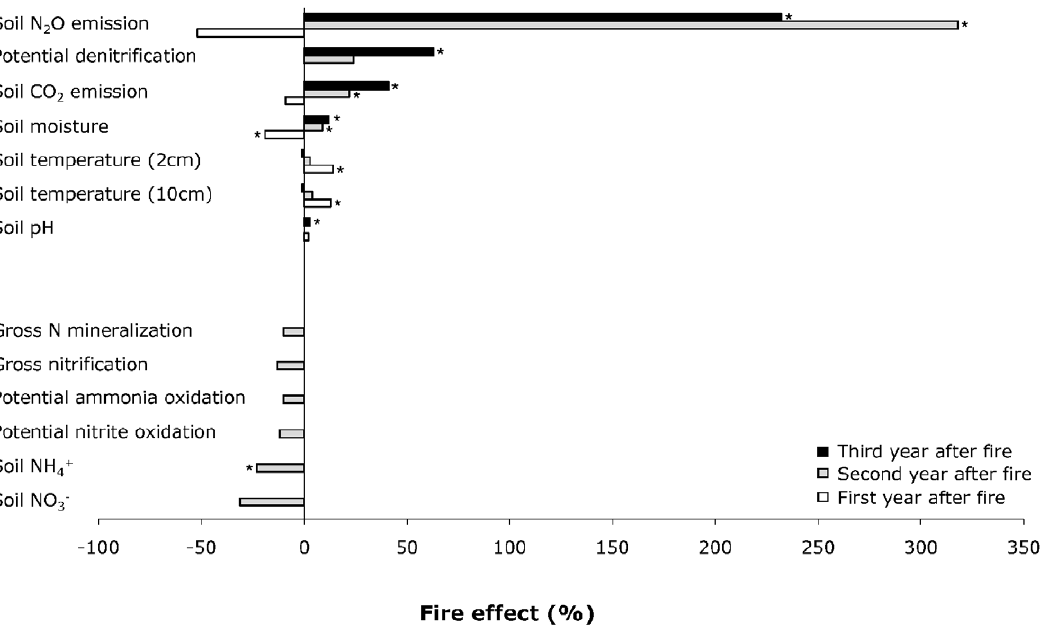
Figure 3. Effects of fire on soil N 2 O emissions, soil characteristics and soil nitrogen cycling. For each variable, bars are arranged chronologically from bottom to top: white bars correspond to data collected during first year after fire (i.e. 9 months after fire), grey bars to data collected for several dates during second year after fire (i.e. 15, 19 and 21 months after fire), and black bars to data collected during third year after fire (i.e. 33 months after fire). The top section shows the response to fire of soil N 2 O emissions, potential denitrification and soil characteristics measured over the three-year period following the fire (with the exception of year one for potential denitrification and of year two for soil pH). The bottom section shows the response to fire of soil N cycling variables measured for several dates in year two after fire. Fire effect sizes were calculated as: % effect=100 6 [burned 2 unburned]/[unburned]. Asterisks next to bars indicate significant effects of fire ( P , 0.05).